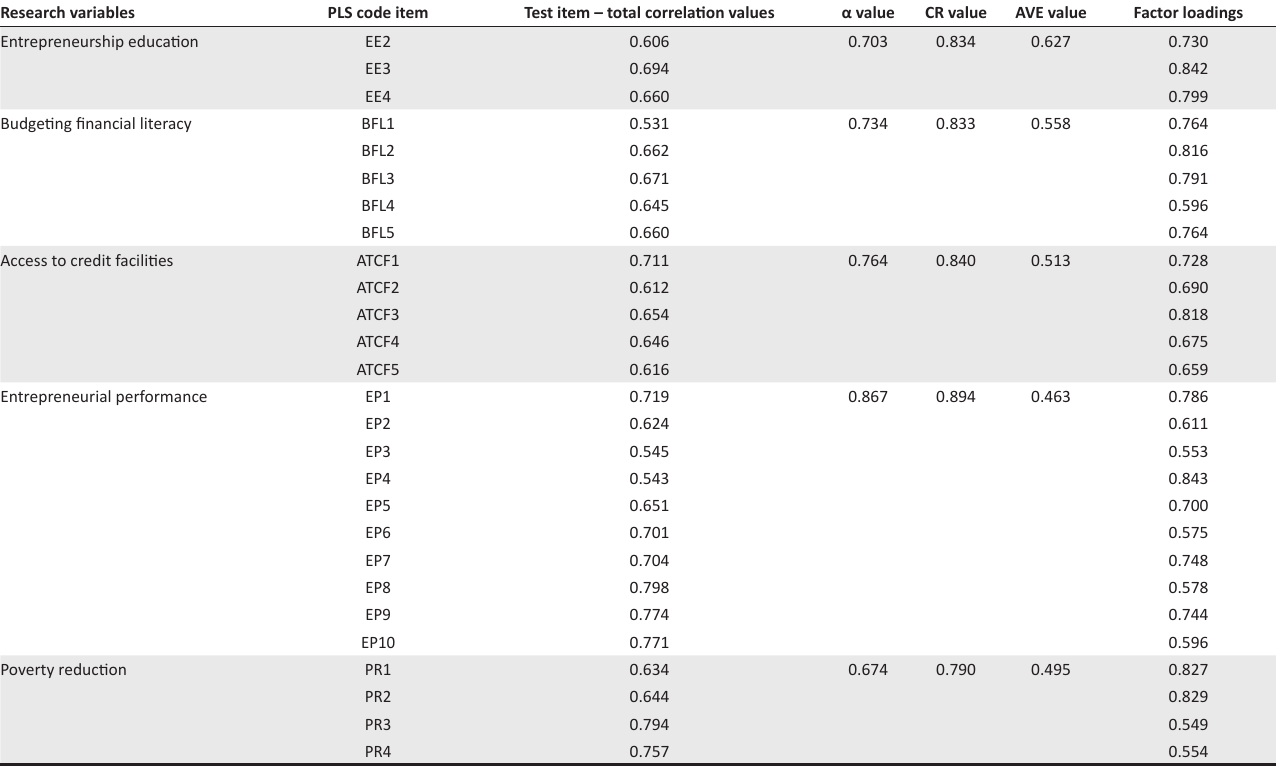
TABLE 1: Accuracy analysis statistics. Research variables